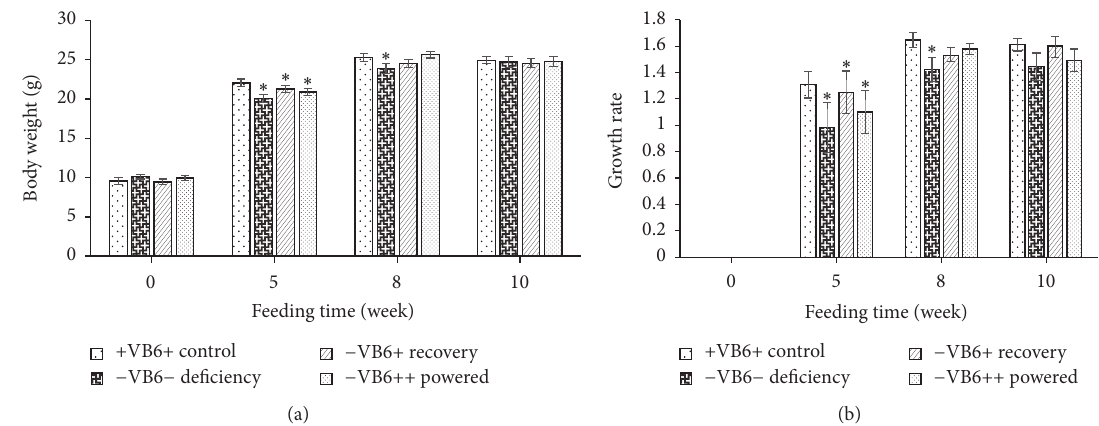
Figure 1: Body weight and body weight gain rate of BLAB/c mice fed with the experiment diets. Growth rate was calculated using the − Body weight )/ Body weight ± SEM ( 𝑛 = 7 ) with formula: Growth rate = ( Body weight 𝑛 0 week 0 week . Each column represents the mean week three independent experiments. Mean values with asterisk ( ∗ ) attached indicate significant difference ( 𝑃 < 0.05 ) among the groups at the same time